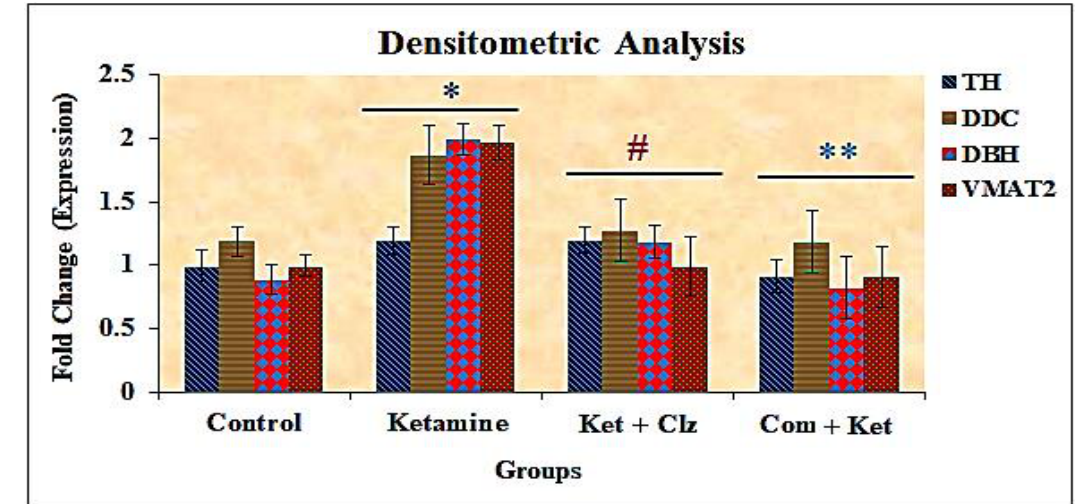
Figure 10. Effects of plant compound and clozapine on the expression of DOPA genes during ketamine-induced alterations in vitro (fold change). All the values are expressed as means ± SD of six individuals. * Significant at p < 0.05 compared with control; # and ** significant at p < 0.05 compared with ketamine-treated group. TH: Tyrosine hydroxylase. DDC: Dopamine decarboxylase. DBH: Dopamine beta hydroxylase. VMAT2: Vesicular monoamine transporter 2.